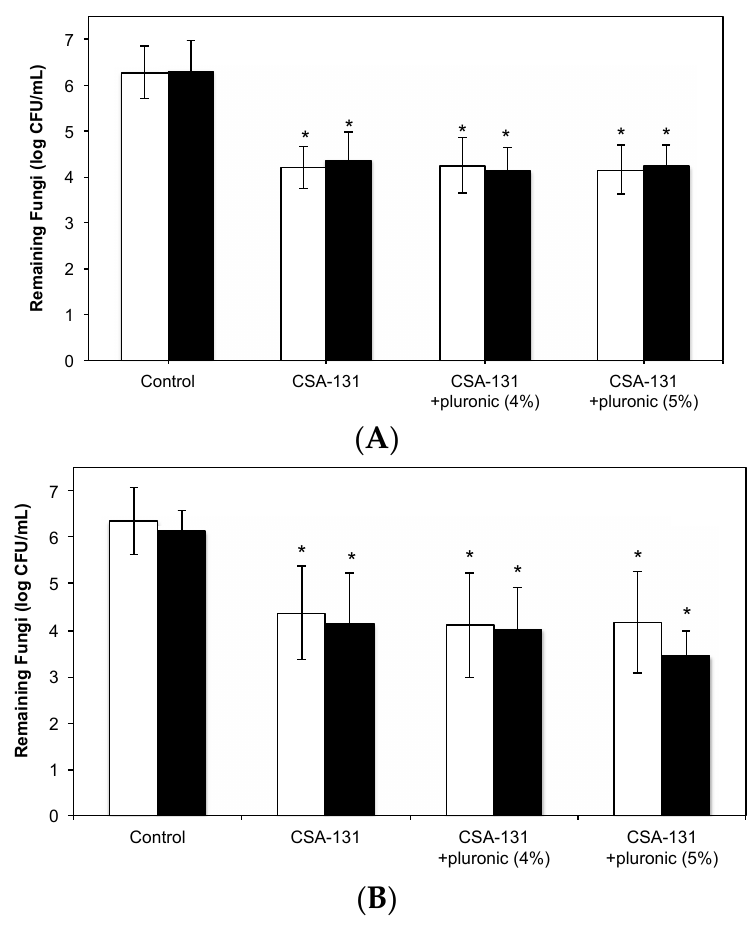
Figure 7. Fungi remaining in tissue explants after incubation for two hours followed by treatment with CSA-131 (with and without pluronic (4% or 5%) for one hour. White bars: C. albicans (ATCC 90028); black bars: C. auris (CDC 384). ( A ) trachea explants; ( B ) lung explants.